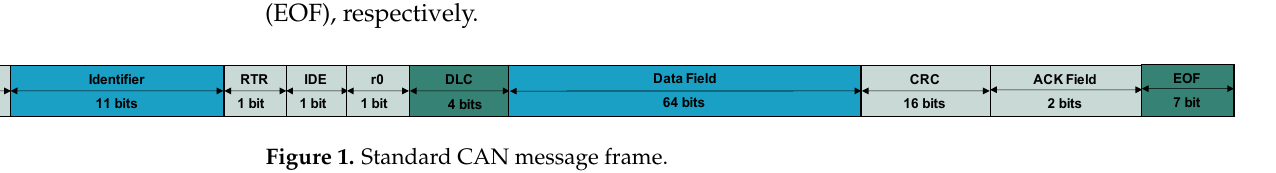
Table 1. DBC file content